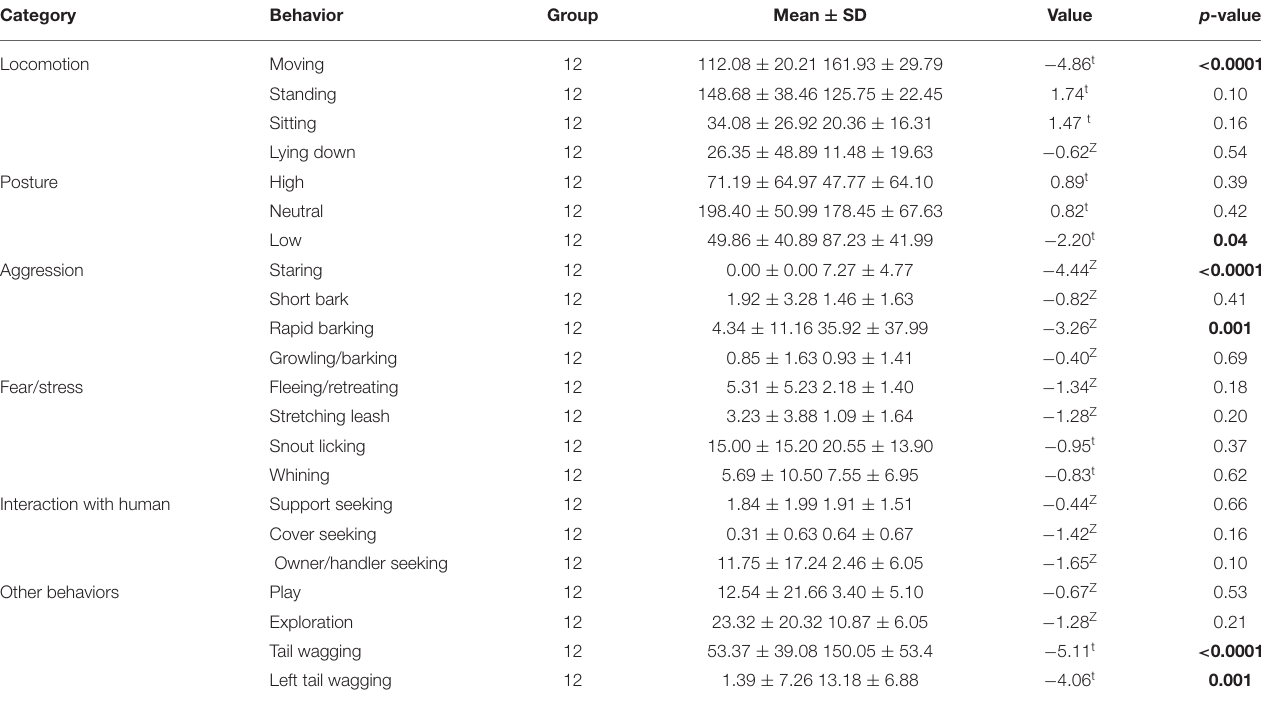
TABLE 2 | Behavioral differences in the SAB test between dog